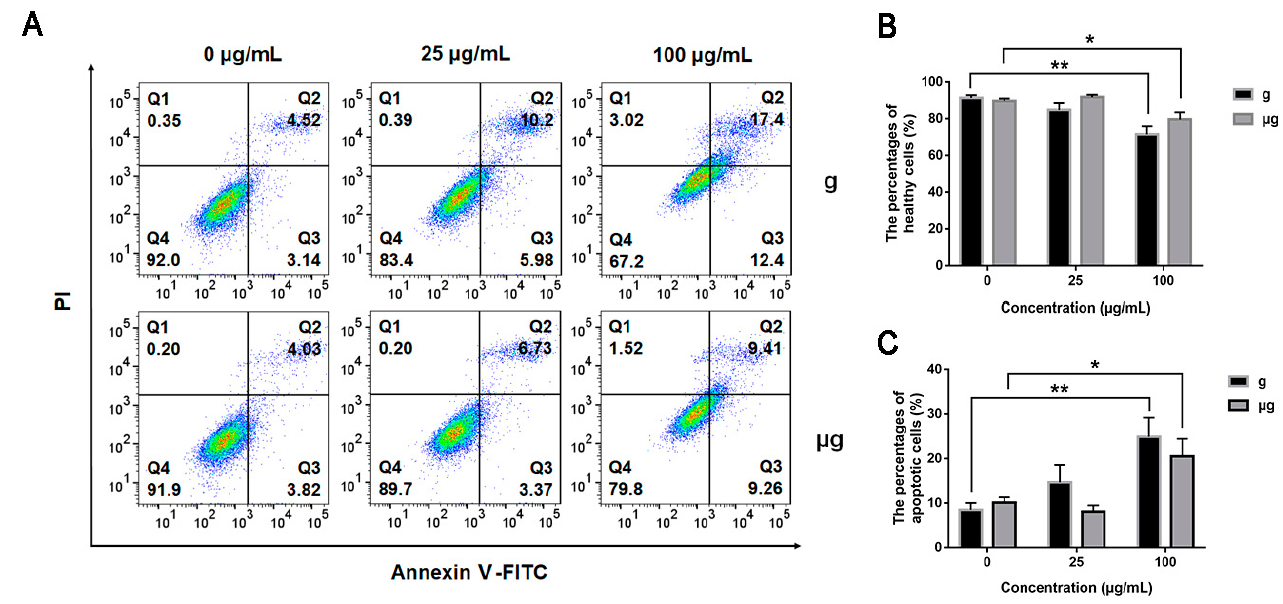
Figure 3. Cytotoxic effects of TiO 2 NPs exposure under normal gravity and simulated microgravity. A549 cells were treated with TiO 2 NPs (0, 25 and 100 µ g/mL) for 48 h under normal gravity (g group) or simulated microgravity ( µ g group). ( A ) Apoptosis analysis by flow cytometry using Annexin V-FITC/PI staining kit after 48 h of TiO 2 NPs exposure. Representative results of flow cytometry analysis were shown. The percentages of healthy cells ((Annexin V-FITC) − /PI − ) ( B ) and apoptotic cells ((Annexin V-FITC) +/PI + plus (Annexin V-FITC)+/PI − ) ( C ) were presented. (Annexin V-FITC)+/PI+: late apoptotic/necrotic cells, (Annexin V-FITC) -/PI +: necrotic cells, (Annexin V-FITC)+/PI − : early apoptotic cells, (Annexin V-FITC) − /PI − : viable cells. The histograms represent the mean ± SD of at least three independent experiments. * p < 0.05, ** p < 0.01.